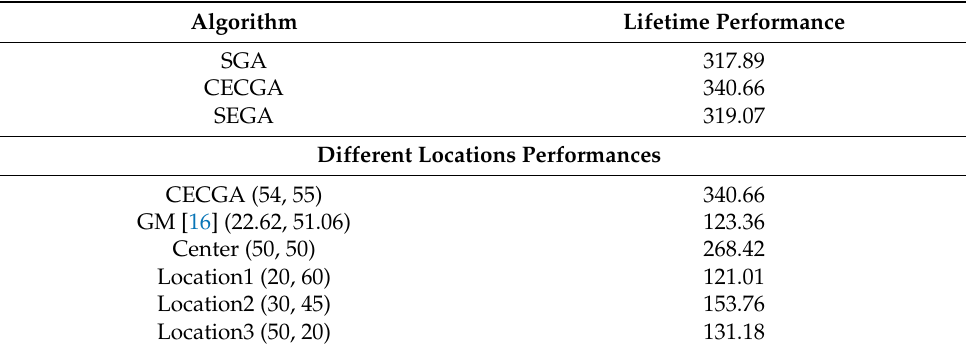
Figure 8. Network lifetime performance. Table 3. Lifetime performance